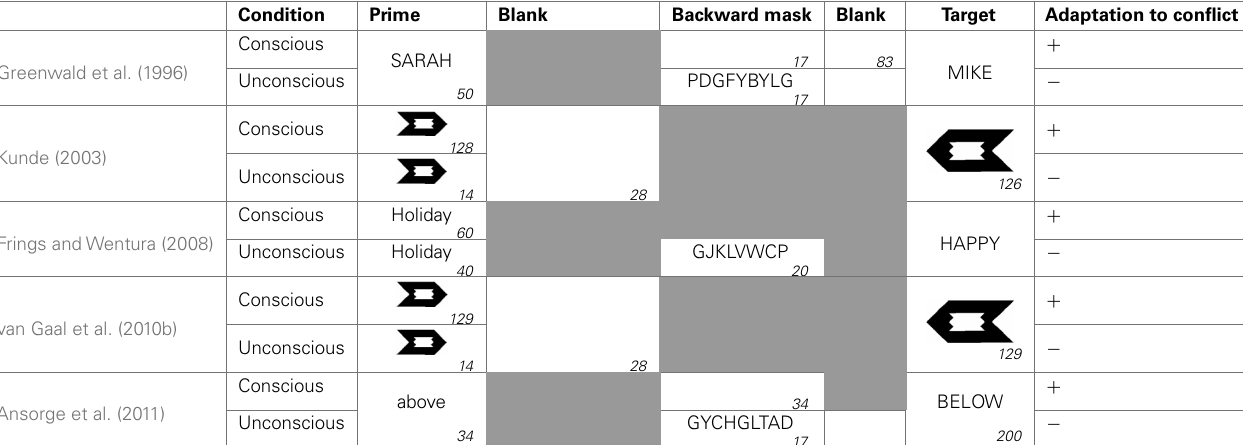
Table 1 | Schematic overview of studies looking at adaptation to conflict on a trial-by-trial basis. Condition Prime Blank Backward mask Blank Target Adaptation to conflict Greenwald et al.